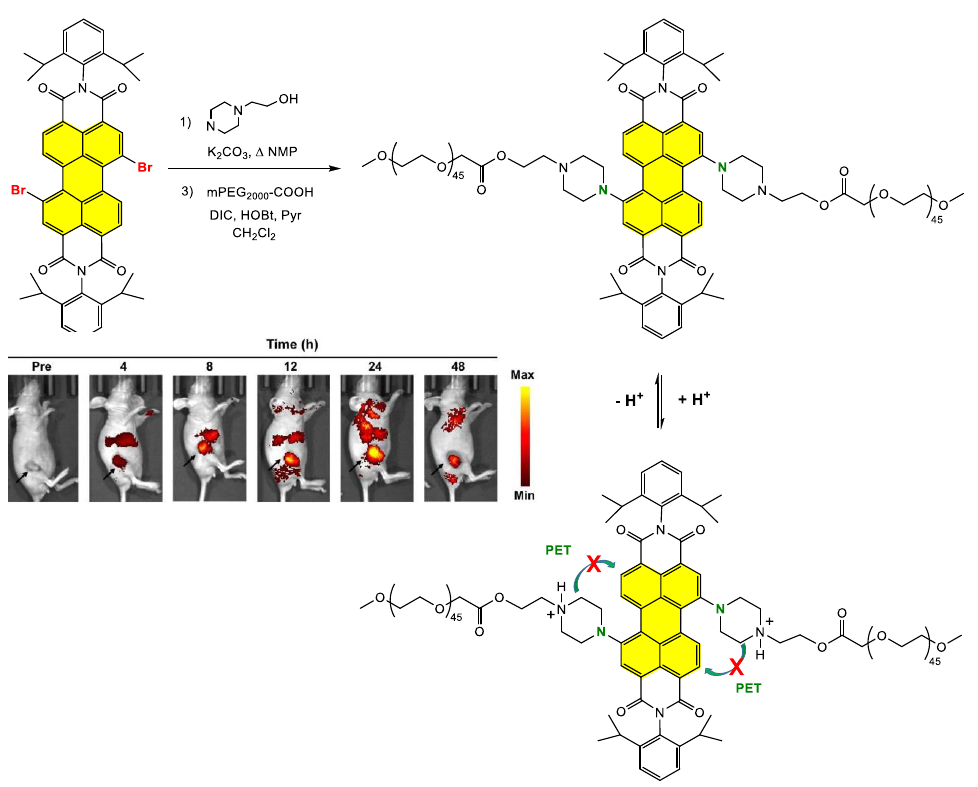
Figure 29. Synthesis of PDI-PEG; representation of PDI-PEG NPs; UV-Visible absorption spectrum of PDI-PEG. Reprinted with permission from reference [140]. Copyright 2018 Elsevier.